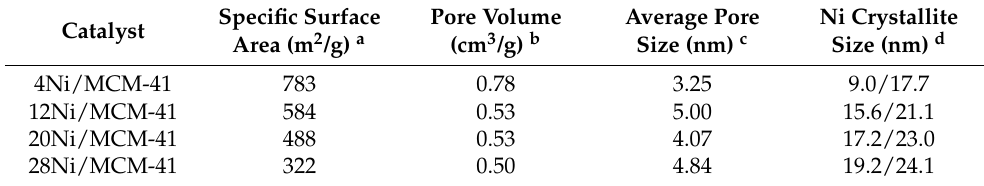
Table 3. Textural properties and Ni crystallite size of fresh and spent x Ni/MCM-41 catalysts.